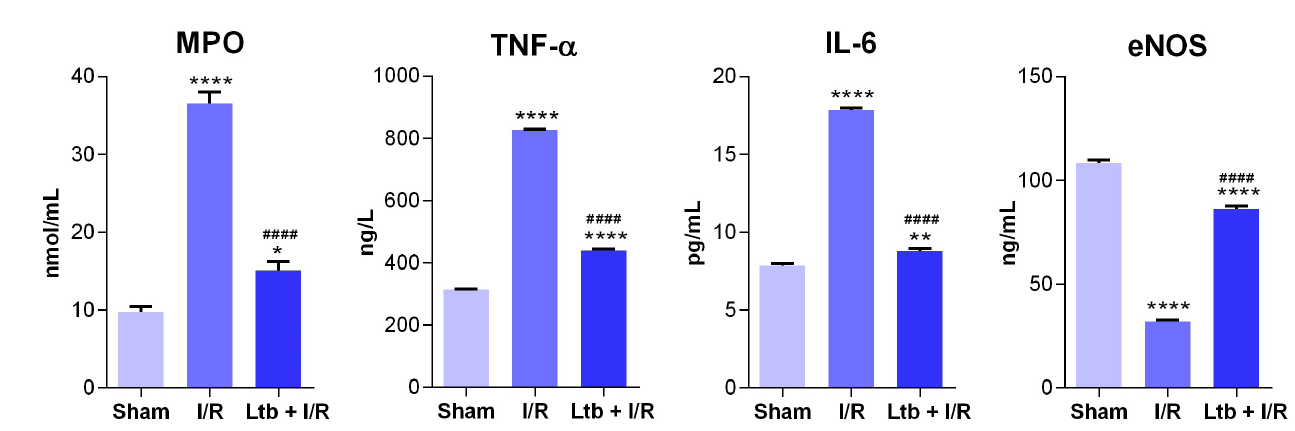
FIGURE 2 - The effects of lithium tetraborate the MPO, TNF-α, IL-6 and eNOS levels on heart after I/R injury. Data are presented as mean ± SEM (n=7). * denotes significant differences between other studied groups and sham ( * : p<0.05, ** : p<0.01, **** : p<0.0001), # denotes significant differences between other studied groups and I/R group ( #### : p<0.0001) by Tukey’s multiple range tests. Abbreviation used: I/R: Ischaemia/Reperfusion, Ltb: Lithium